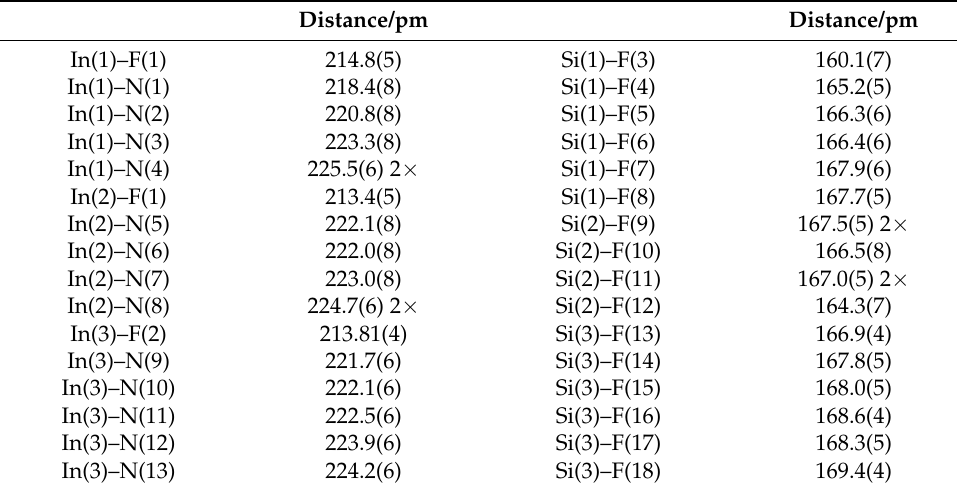
Table 9. Selected interatomic distances in [In 2 F(NH 3 ) 10 ] 2 [SiF 6 ] 5 · 2 NH 3 . Distance/pm